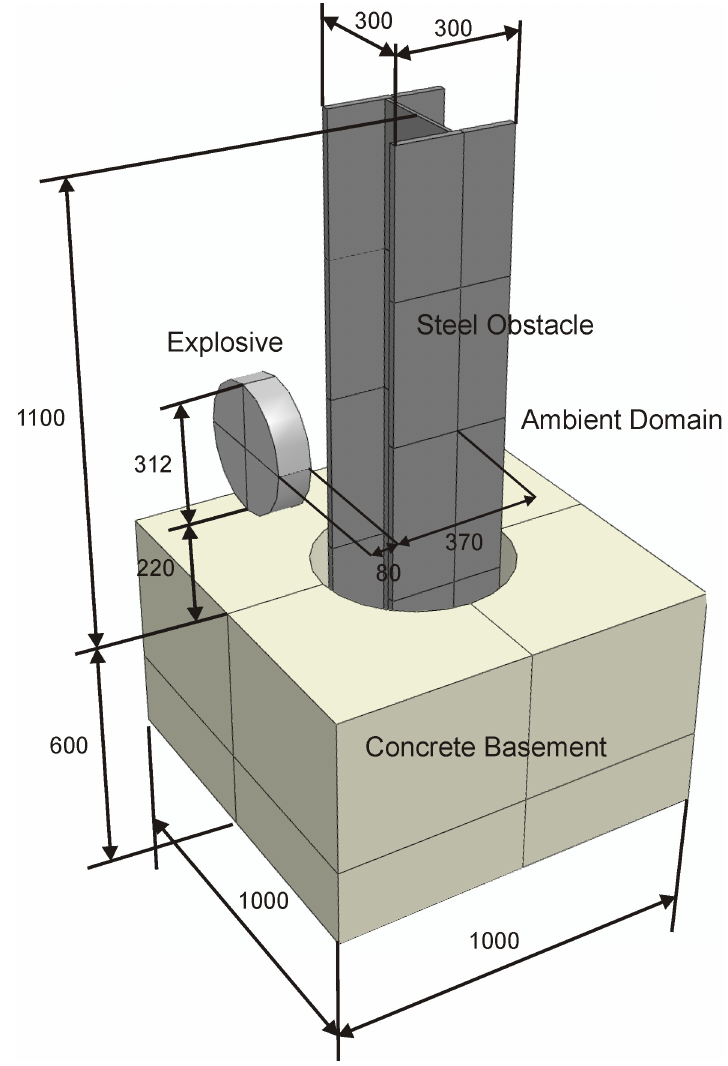
Figure 2. Steel column with cylindrical TNT (dimensions are in